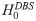
Conditions for pole-zero cancellation.(A) For clinically relevant DBS parameters (fDBS ≳ 100 Hz, δ ∼ 60-100 μs), the pole-zero cancellation produces the total suppression of frequencies above the β-band, specifically, in the γ-band from 30 to 40 Hz (thick red curve). (B) Stimulation amplitude H0DBS as a function of the stimulation frequency fDBS for different pulse widths δ. This result shows that the required amplitude H0DBS decreases with increasing fDBS and δ, suggesting that the pole-zero cancellation mechanism depends only on the power delivered by the stimulation.